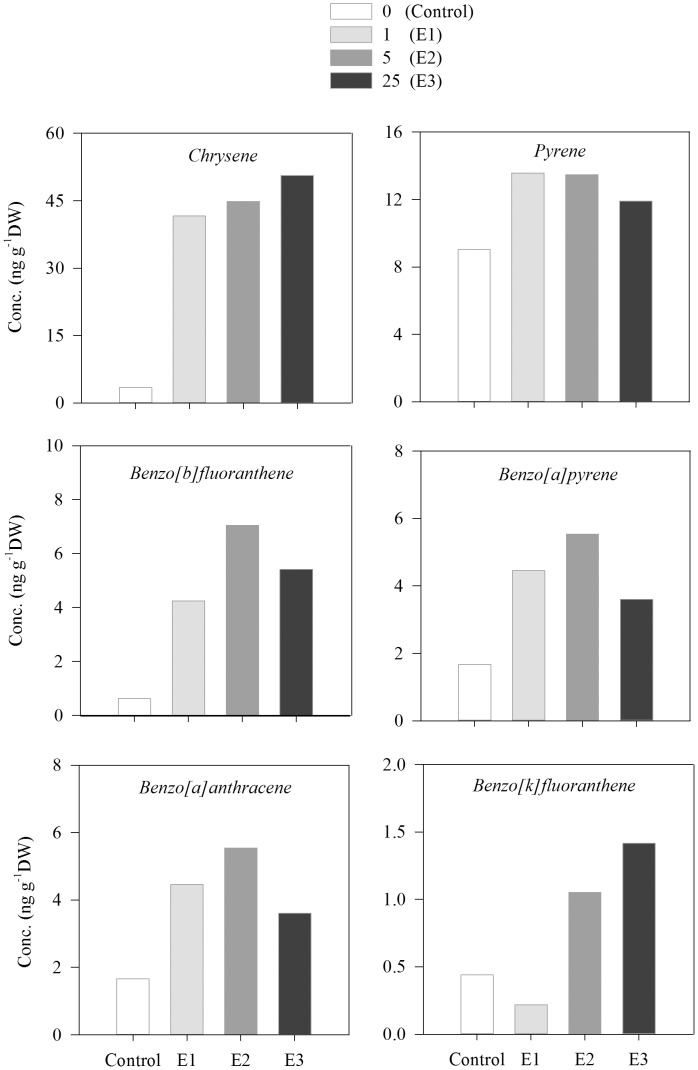
Concentration of the main polycyclic aromatic hydrocarbons (PAHs) detected in adult stages of ctenophore Mnemiopsis leidyi after 6 days of exposure to different crude oil concentrations.(Control: no oil, E1: 1 µL L−1, E2: 5 µL L−1, E3: 25 µL L−1.)